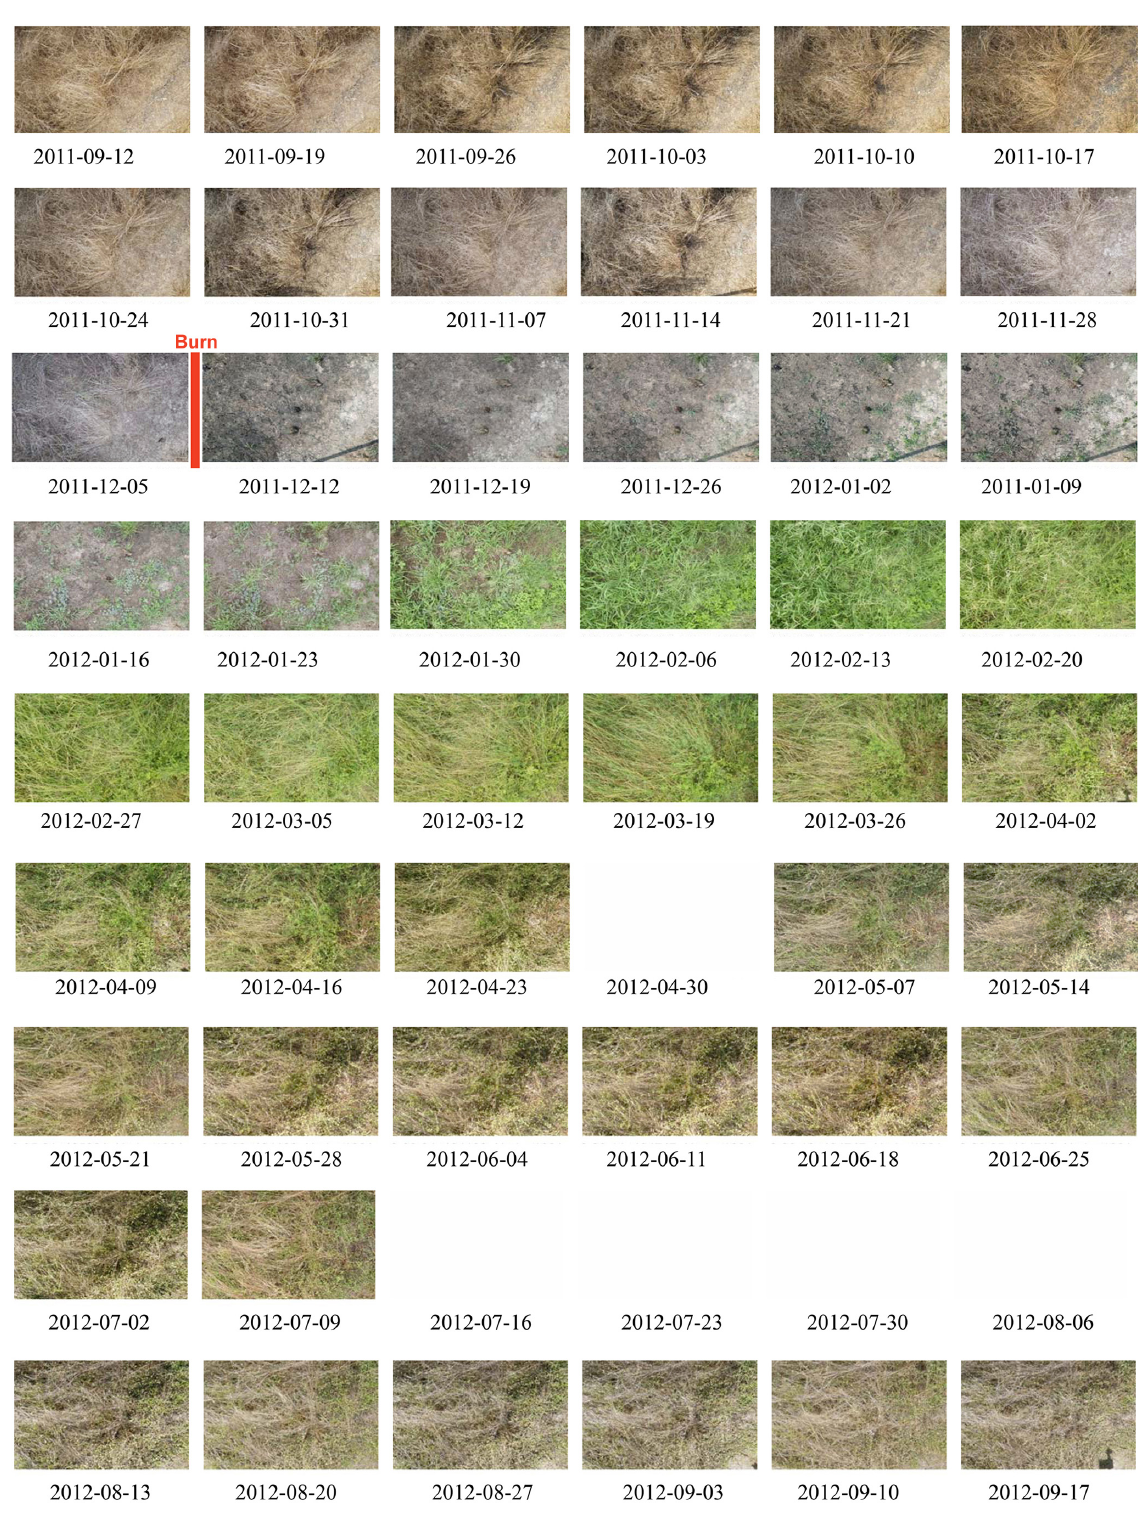
Figure 6. Time series of a year of images from the digital camera at the fenced node, with each week represented by one image from approximately noon. The red line indicates the controlled burn in December 2011. Missing July images are due to a post-capture storage malfunction unrelated to the image capture. An animation of camera images is available (Handcock,